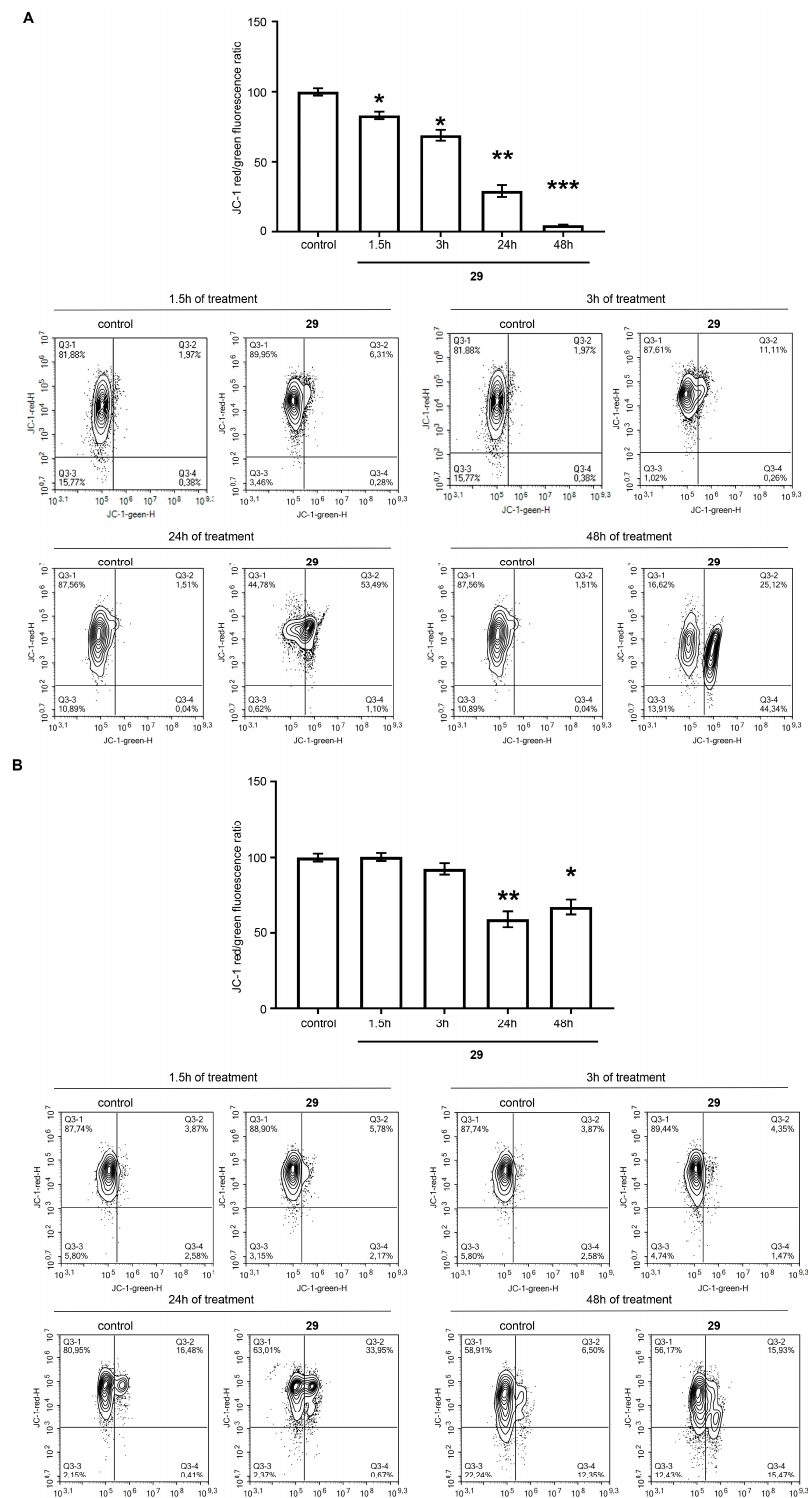
Figure 5. Mitochondrial membrane depolarization in HEK293 ( A ) and MCF-7 ( B ) cells upon compound 29 treatment. Cells were treated with compound 29 for 1.5, 3, 24 and 48 h. Data are expressed as mean ± S.E.M from two experiments, performed in triplicate (*— p < 0.05, **— p < 0.01, ***— p < 0.001 compared with control (untreated) cells; Wilcoxon t -test).